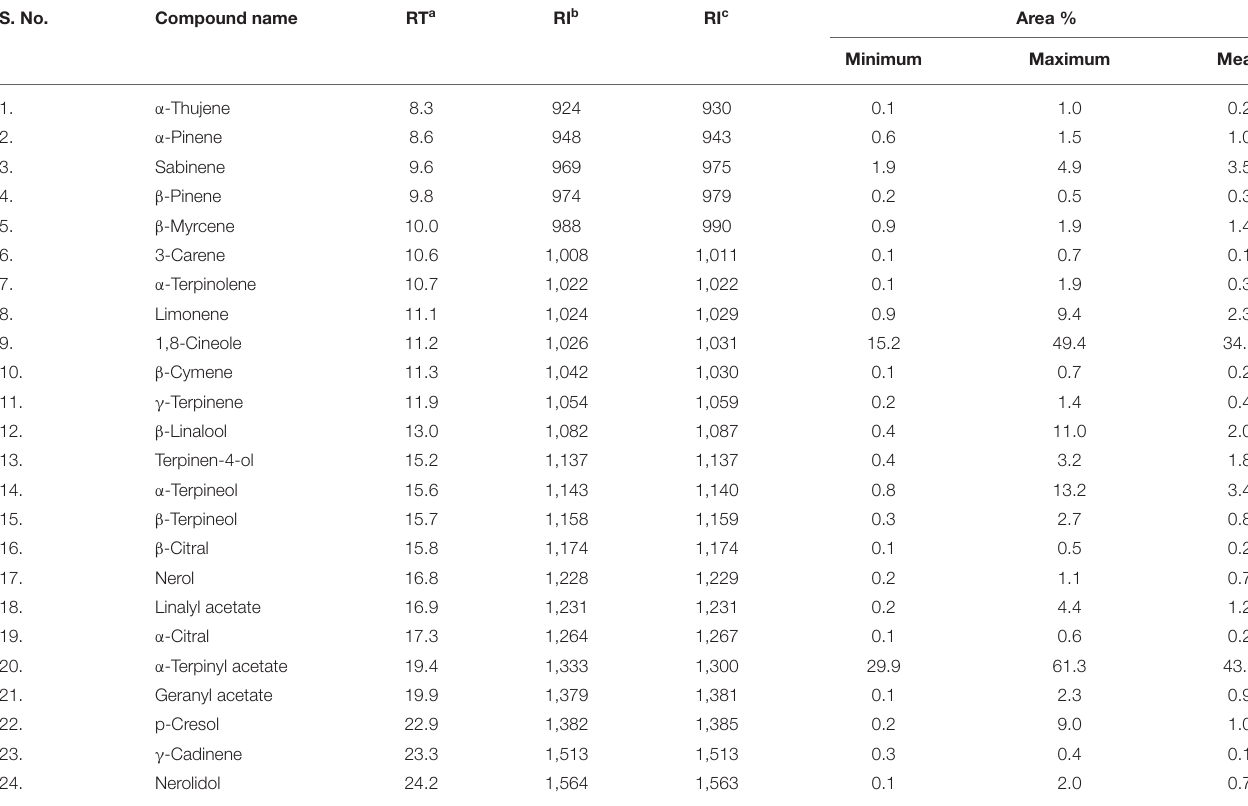
TABLE 1 | Minimum and maximum range, retention time, retention index of essential oil compounds in 22 cardamom accessions. S.